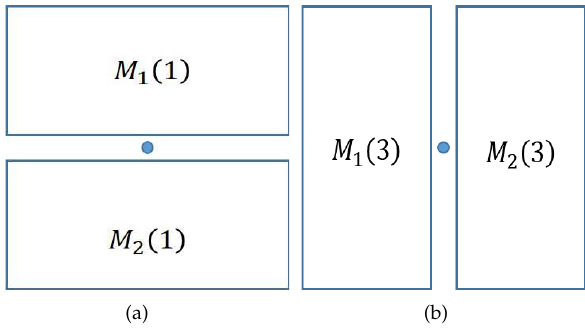
Figure 1. Scheme of the ratio of average (ROA). ( a ) The ratio of the local means for the horizontal direction. ( b ) The ratio of the local means for the vertical